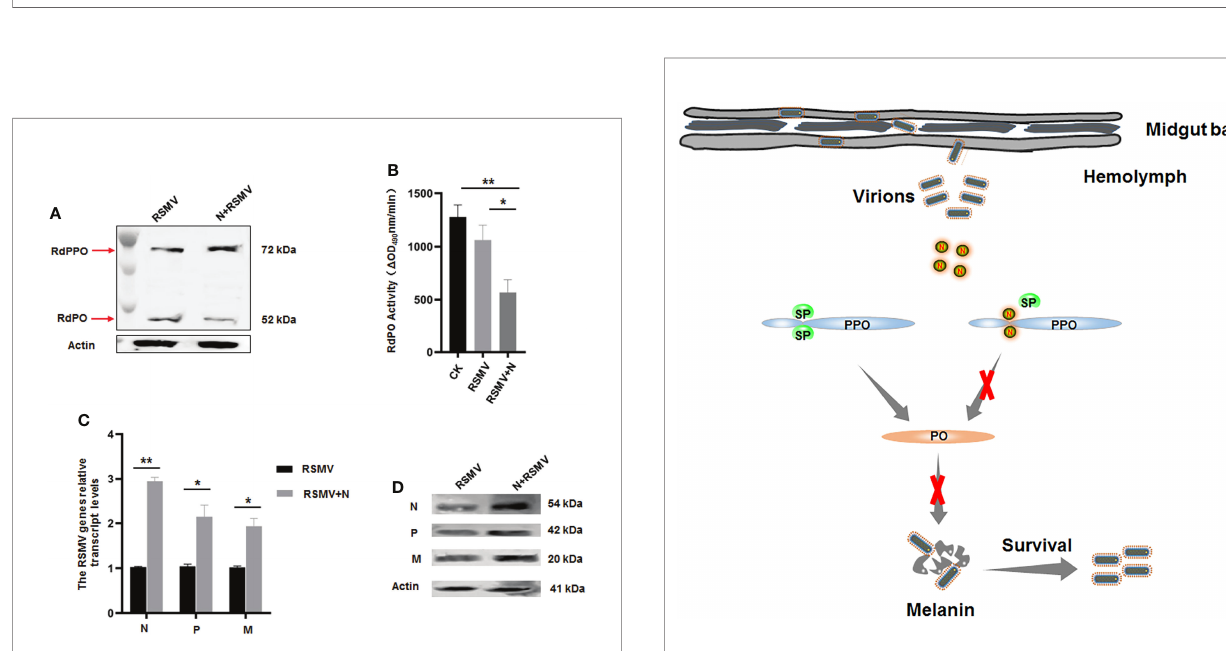
FIGURE 6 | Microinjected puri fi ed N protein impairs PO activity and facilitates RSMV infection in R. dorsalis . (A) PPO and PO levels in viruliferous R. dorsalis microinjected with or without puri fi ed N determined via immunoblotting with PPO-speci fi c antibody. The bands of PPO and PO are indicated. (B) Variations in PO activity in viruliferous R. dorsalis after injection of puri fi ed N. Hemolymph samples were collected at 5 d post injection and subjected to activity assays. (C) RT-qPCR showing the transcript levels of RSMV N, P, and M genes in viruliferous R. dorsalis after injection of puri fi ed N. Results are normalized against the Actin expression level. (D) Immunoblotting assay showing the levels of N, P and M proteins in viruliferous R. dorsalis after injection of puri fi ed N. Insect Actin protein was used as an internal control. *P < 0.05; **P <